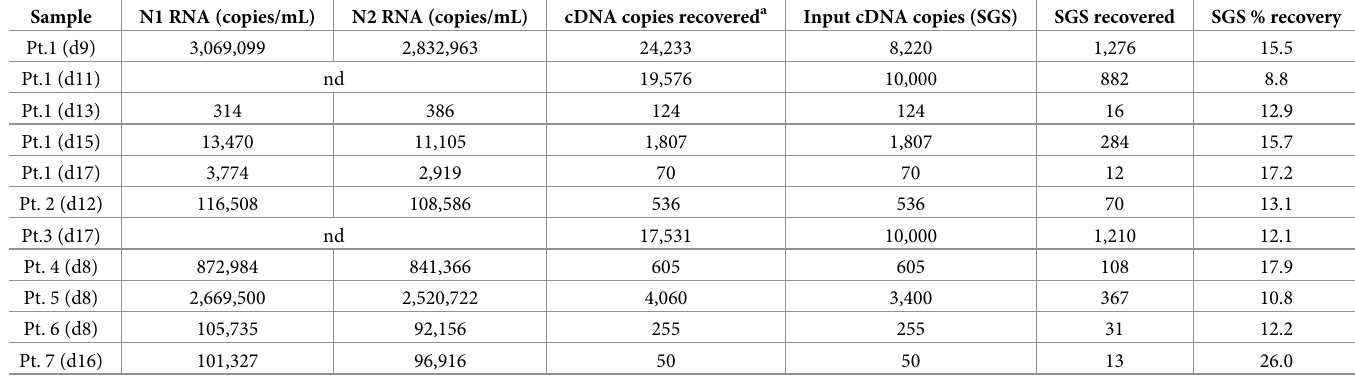
Table 2. Virus loads and recoveries of cDNA and final SGS in HT-SGS from upper respiratory swab samples. Sample N1 RNA (copies/mL) N2 RNA